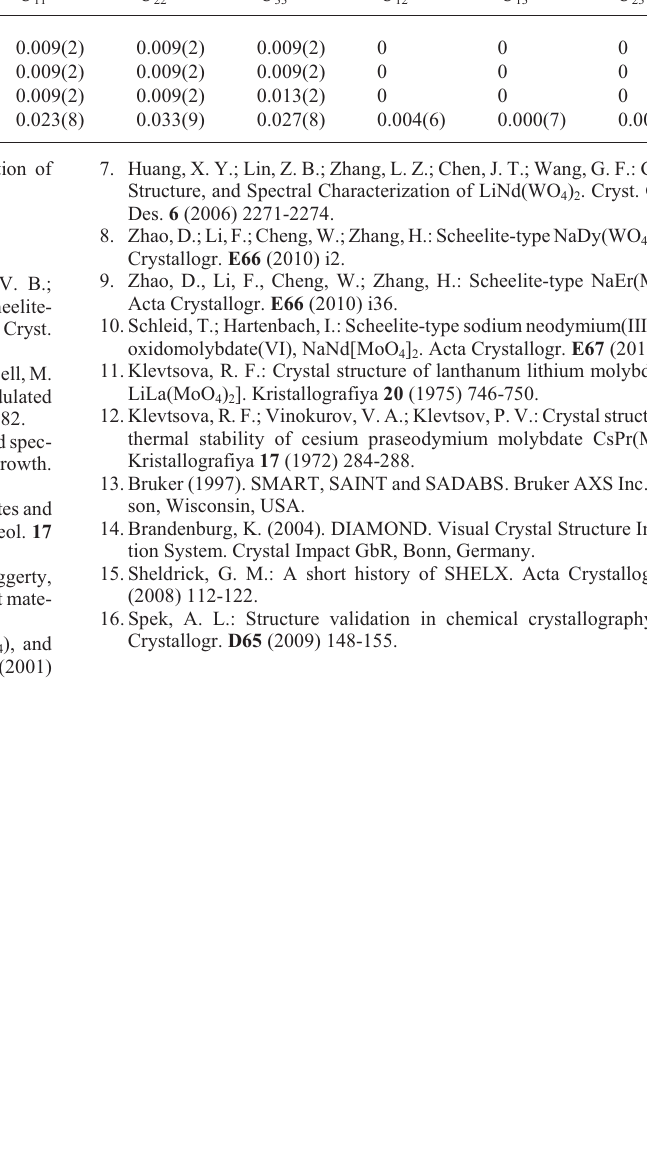
Table 2. Atomic coordinates and displacement parameters (in Å 2 ) . Atom Site